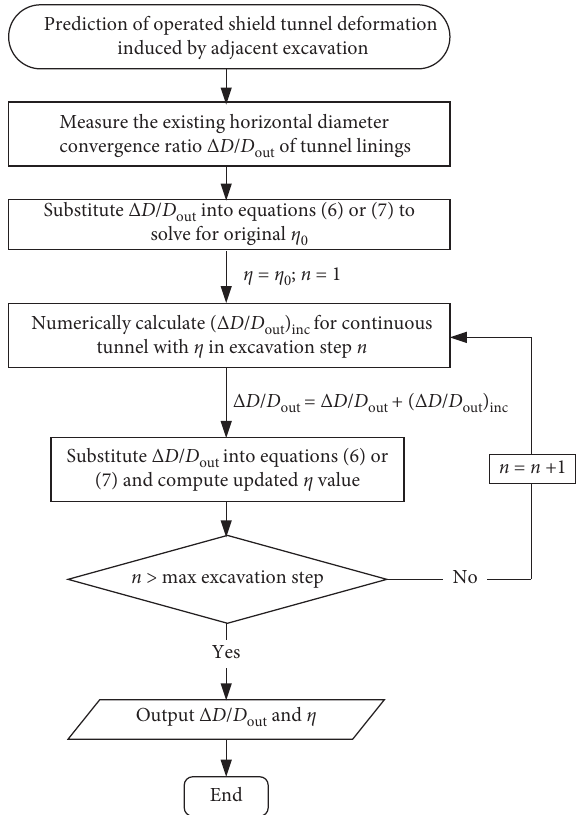
Figure 18: The flowchart of the specific deformation prediction